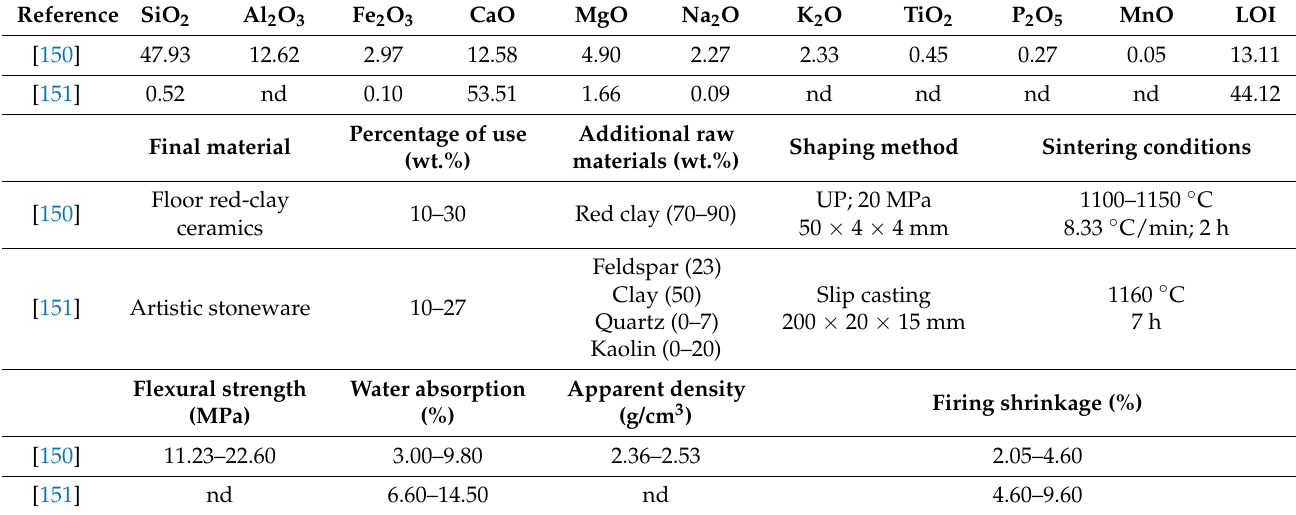
Table 22. Chemical composition (expressed wt.% oxide), processing parameters and technological properties of ceramic materials developed from marble waste.